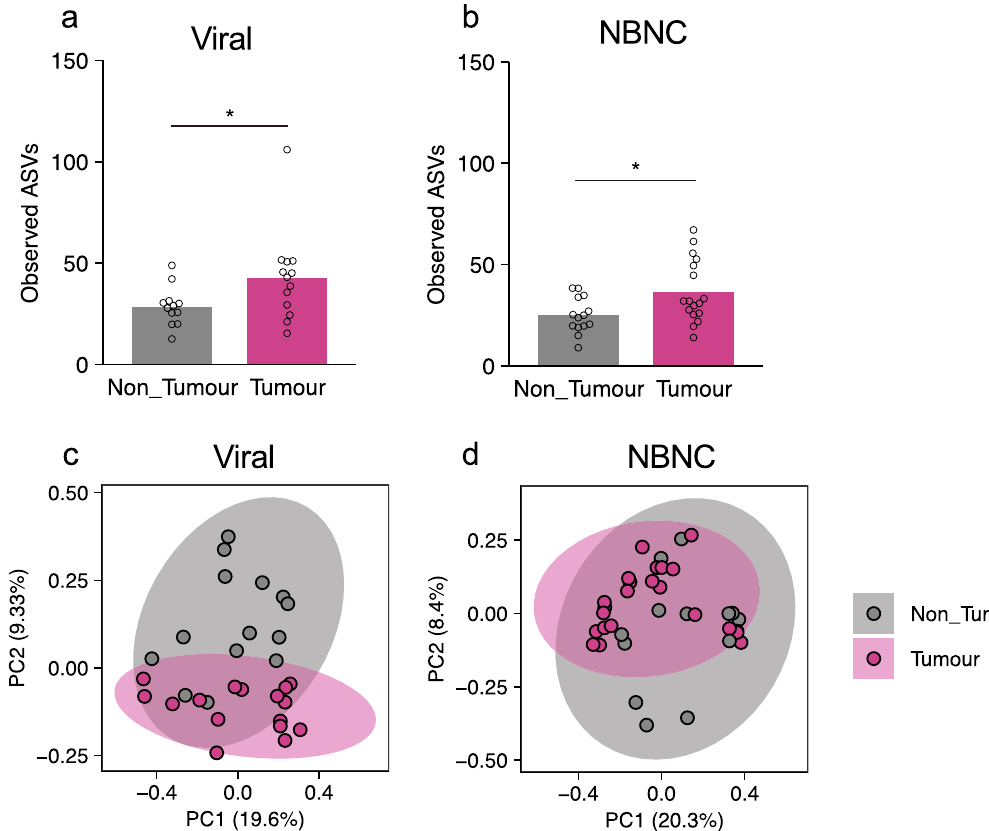
Figure 3. Microbial signature of the non-tumour and tumour regions of viral and NBNC HCC. ( a , b ) Species richness (observed ASVs) of the microbiota in the non-tumour and tumour regions of viral ( a ) or NBNC HCC ( b ). ( c , d ) Principal component analysis of unweighted UniFrac distances among the microbiota in the non- tumour and tumour regions of viral ( c ) or NBNC HCC ( d ). Each bar represents mean, and the values of each sample are indicated with dots. Significant differences are indicated at the top of the panels (* p < 0.05; Wilcoxon rank sum